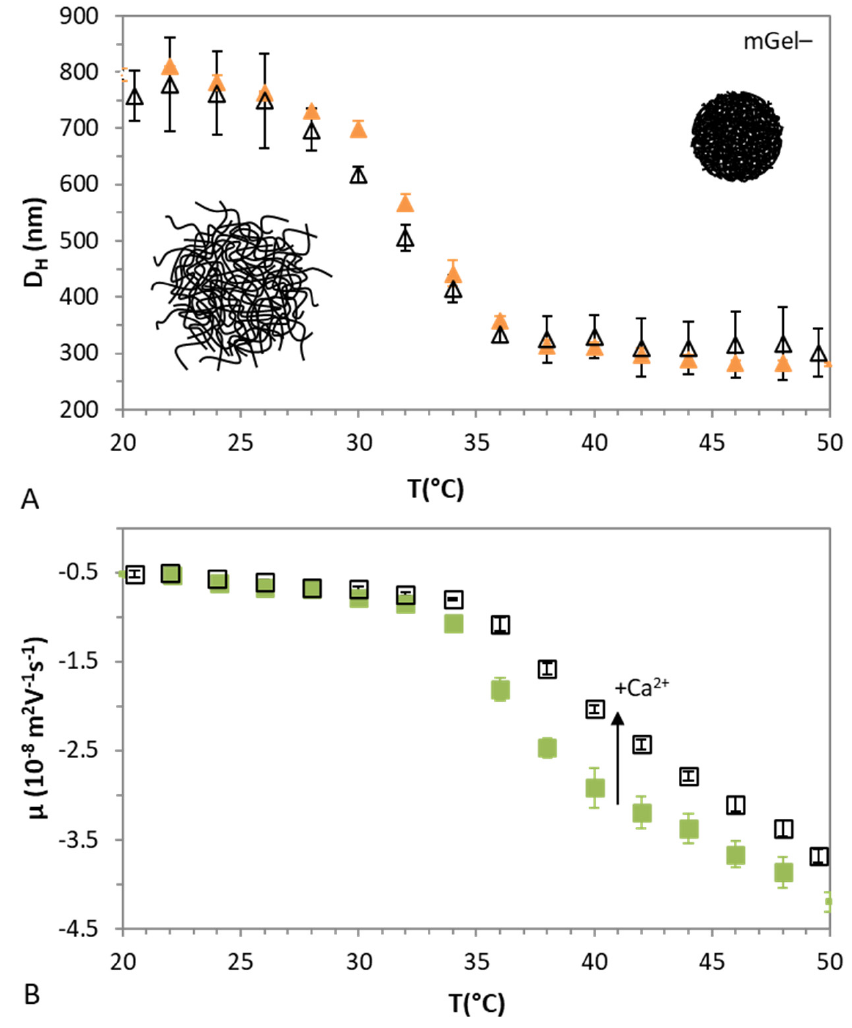
Figure 5. ( A ) Hydrodynamic diameter and ( B ) electrophoretic mobility of mGel − as a function of temperature in water (solid symbols) and in 1 mM Ca(NO 3 ) 2 (open symbols). Values plotted are the mean of three independent measurements with standard deviations.